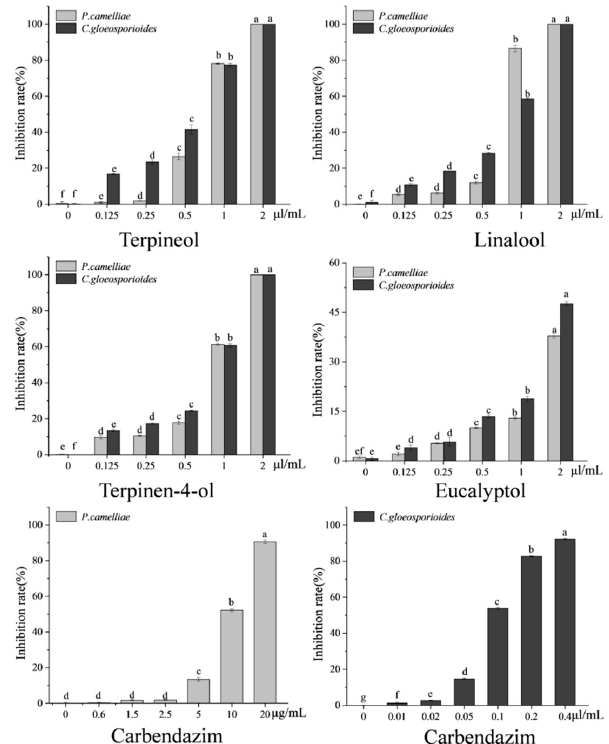
Figure 5. The contact antifungal activity of four major compounds and carbendazim (positive control) against P. camelliae and C. gloeosporioides after 7 days. Percentage values followed by the same letter are not significantly different in the same group at p ≤ 0.05 (Duncan’s test).